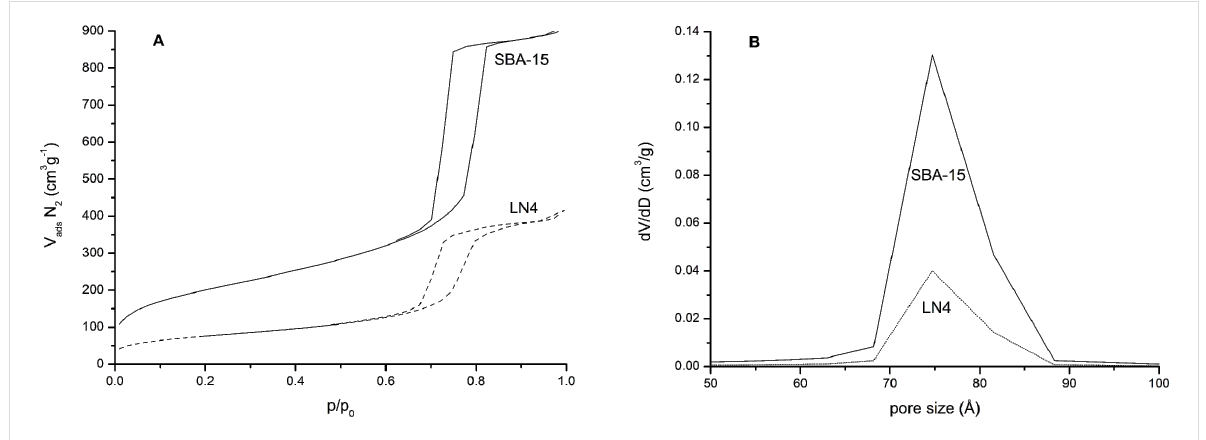
Table 1. The textural properties of the unloaded SBA-15 when treated according to the LiNbO 3 reaction conditions do not change significantly. For both samples, nitrogen